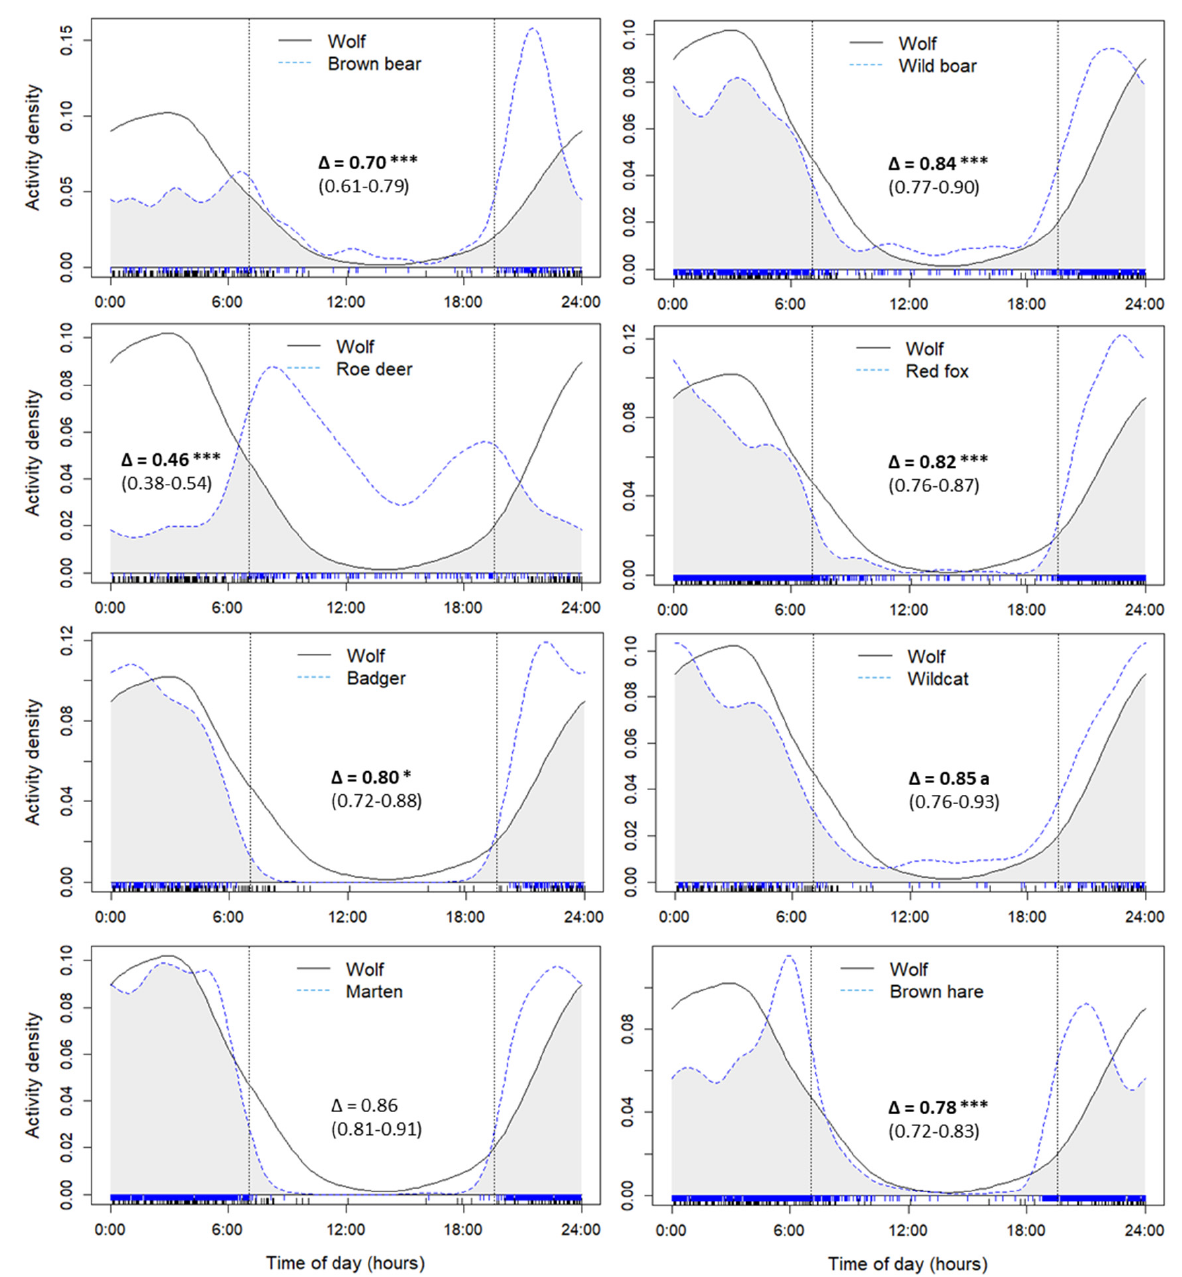
Figure 2. Overlap in temporal activity pattern between wolves and other mammals in Greece, 2019–2020. ∆ : percentage of overlap (95% confidence intervals in parenthesis), indicated in gray shadow. Vertical dashed lines: average sunrise (07:04) and sunset (19:32) times. Bold text: significance level of MWW test (***: p < 0.001, **: p < 0.01, *: p < 0.05, (a) 0.1 < p < 0.05).